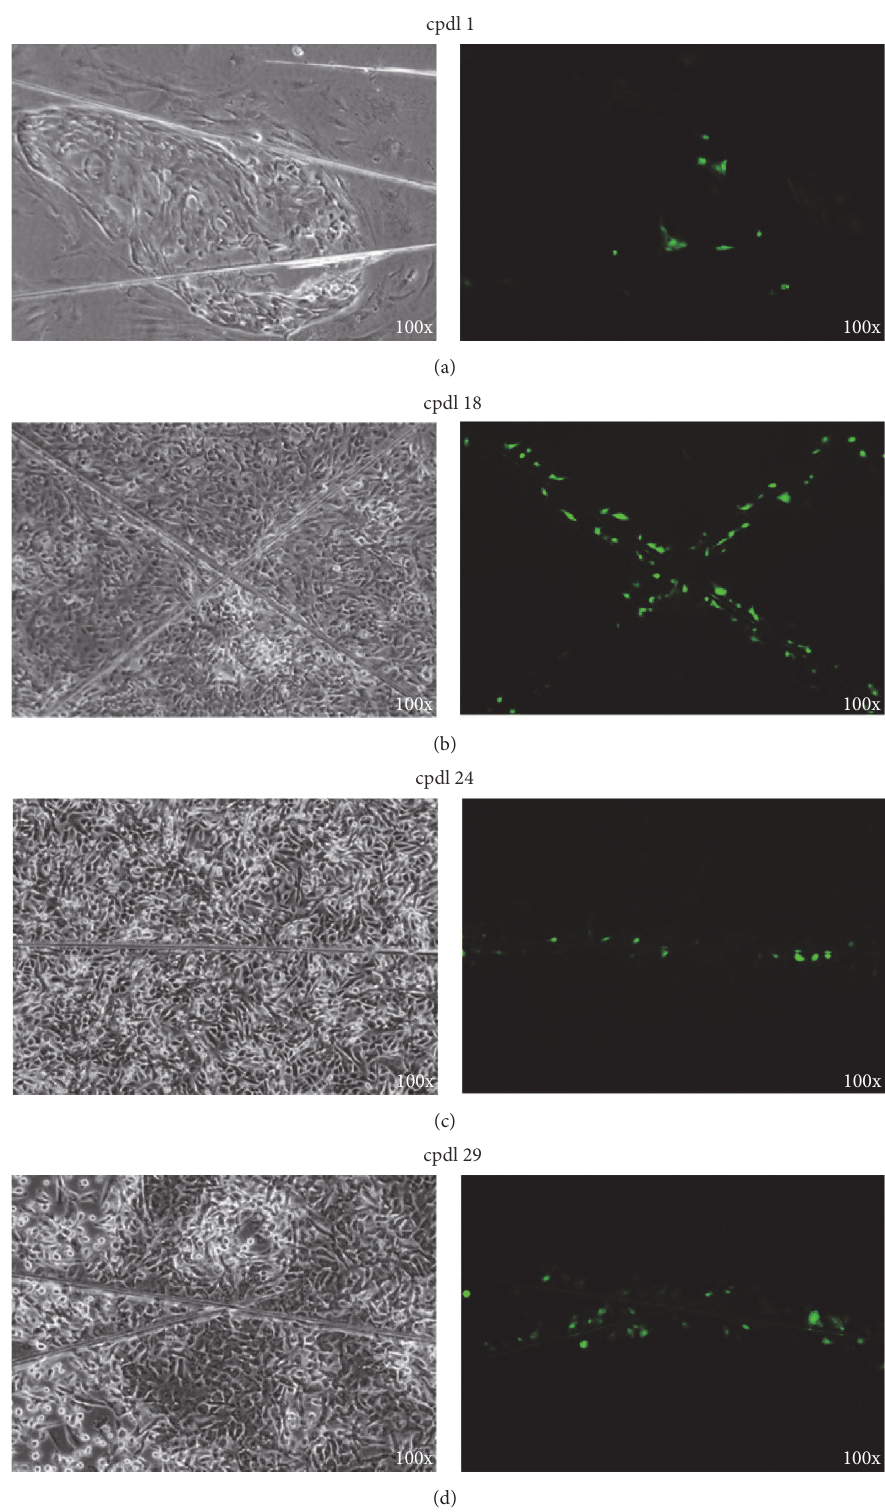
Figure 3: Gap junctional intercellular communication of Type I HBECs cultured in K-NAC medium studied by the Lucifer Yellow scrape loading/dye transfer technique. The results show that Type I HBECs in early and middle passage (cpdl = 1, 18, and 24) (a–c) were deficient in dye transfer. In later passage (cpdl 29) (d), the Type I HBECs showed very limited dye transfer. The same area of cells was observed under a phase contrast (left) or fluorescence (right)